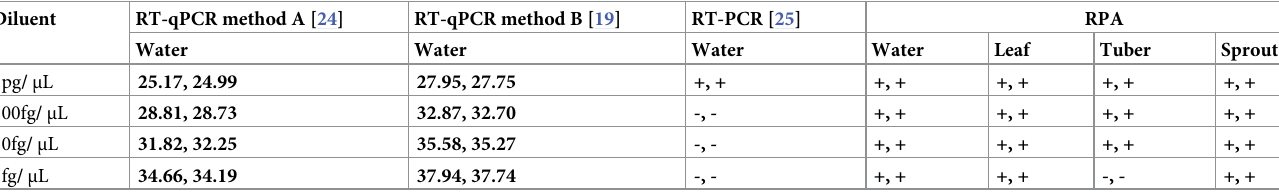
Table 4. Comparative sensitivity analysis between RPA and other published molecular methods for the detection of potato mop-top virus (PMTV). PMTV RNA transcript was diluted and tested in duplicate by following the appropriate protocol for each method. Cq data is provided for the RT-qPCR assays and “+” and “-” indicate samples are positive and negative of PMTV for qualitative assays.